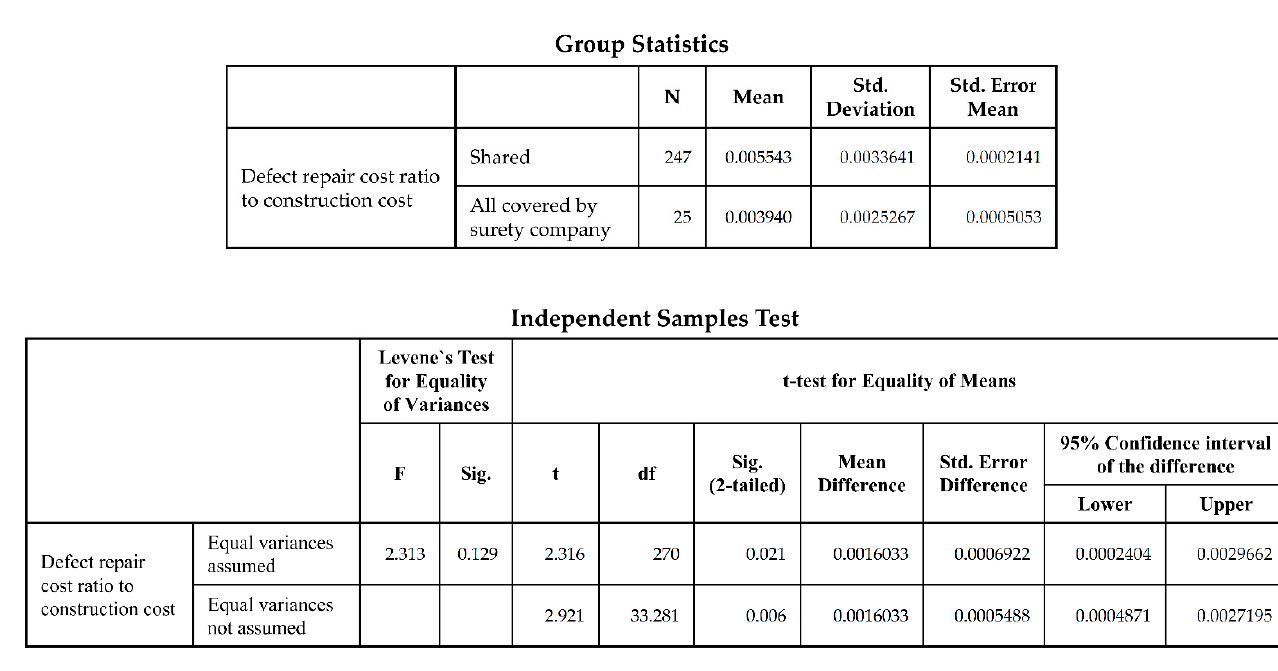
Figure A8. ANOVA result of damage sharing to project entities.